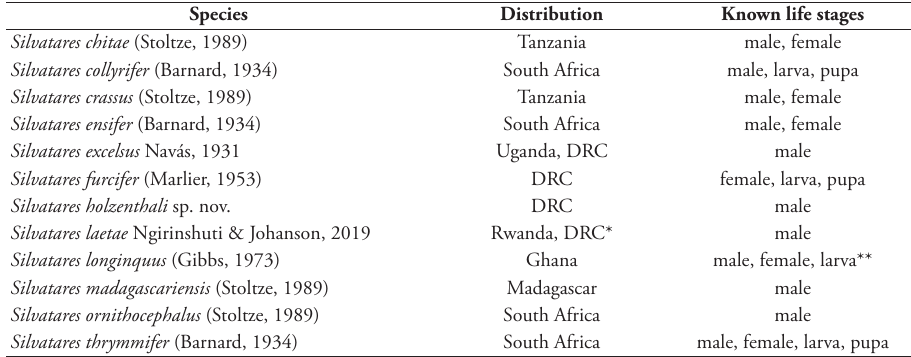
Table 1. Species of Silvatares , with their known distributions and life stages. Species